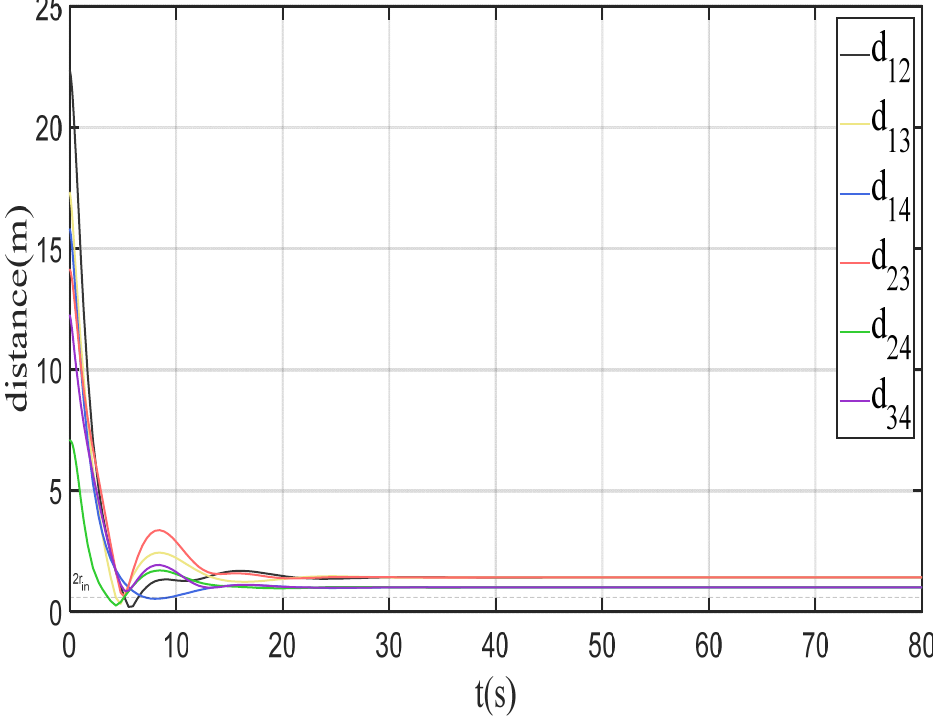
Figure 8. The distance between any two UUVs of the formation without collision avoidance. The position error and velocity error performance are validated as shown in Figures